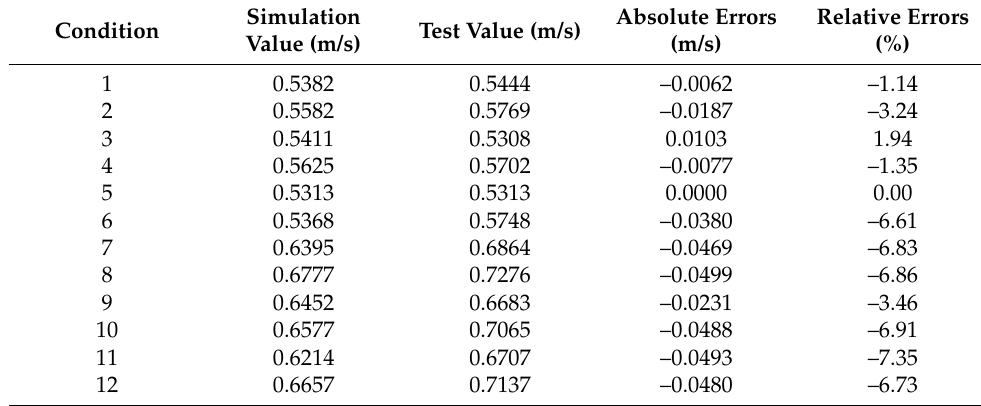
Table 6. The validation of v 2 .